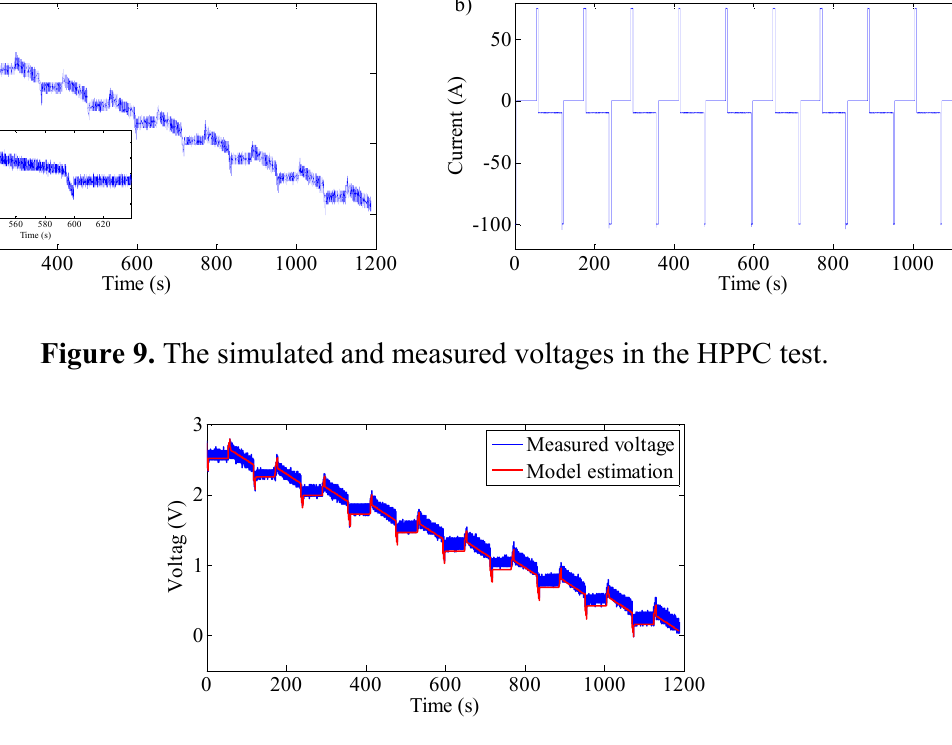
Figure 10. The error between the simulated and measured voltages in the HPPC